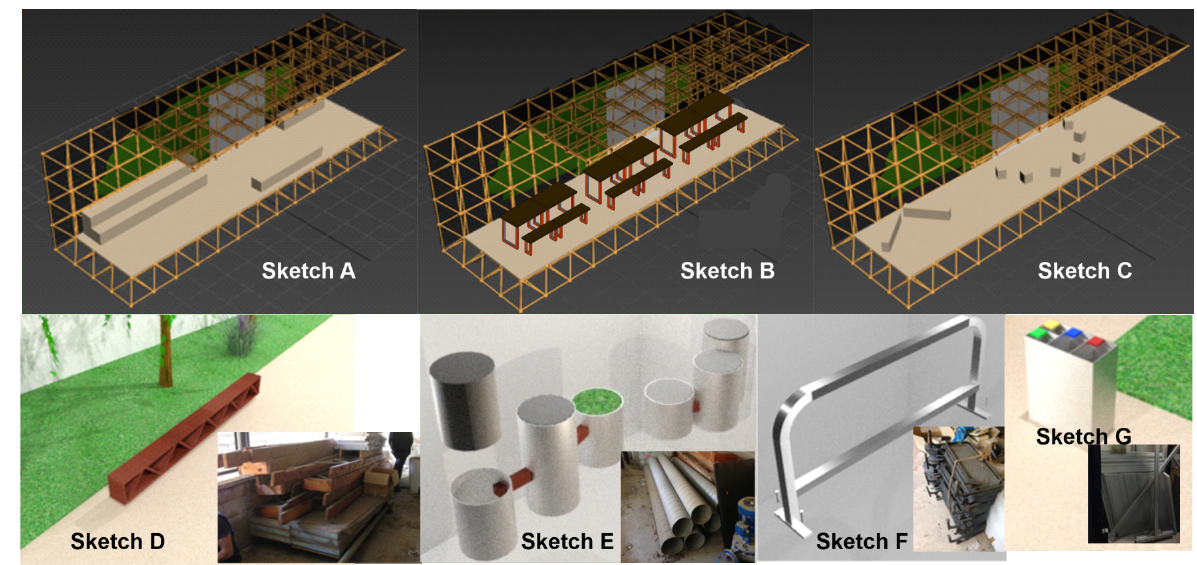
Figure 7. Sketches of furniture for Smart-Tree: ( A ) structure with wooden benches; ( B ) structure with tables and work- benches; ( C ) round table version with wooden cubes, plus annex of rectangular benches; ( D ) bench implemented with wooden beams; ( E ) bench with metal tubes and concrete; ( F ) bicycle rack with handrails; ( G ) recycling container with metal shelves.